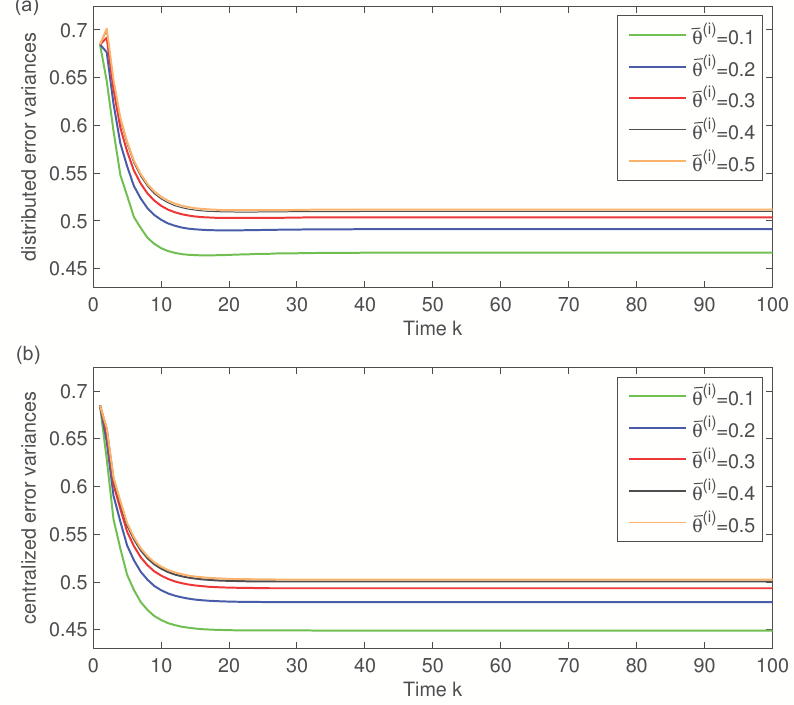
Figure 2. ( a ) Distributed filtering error variances and ( b ) centralized filtering error variances for ( i ) different values of θ